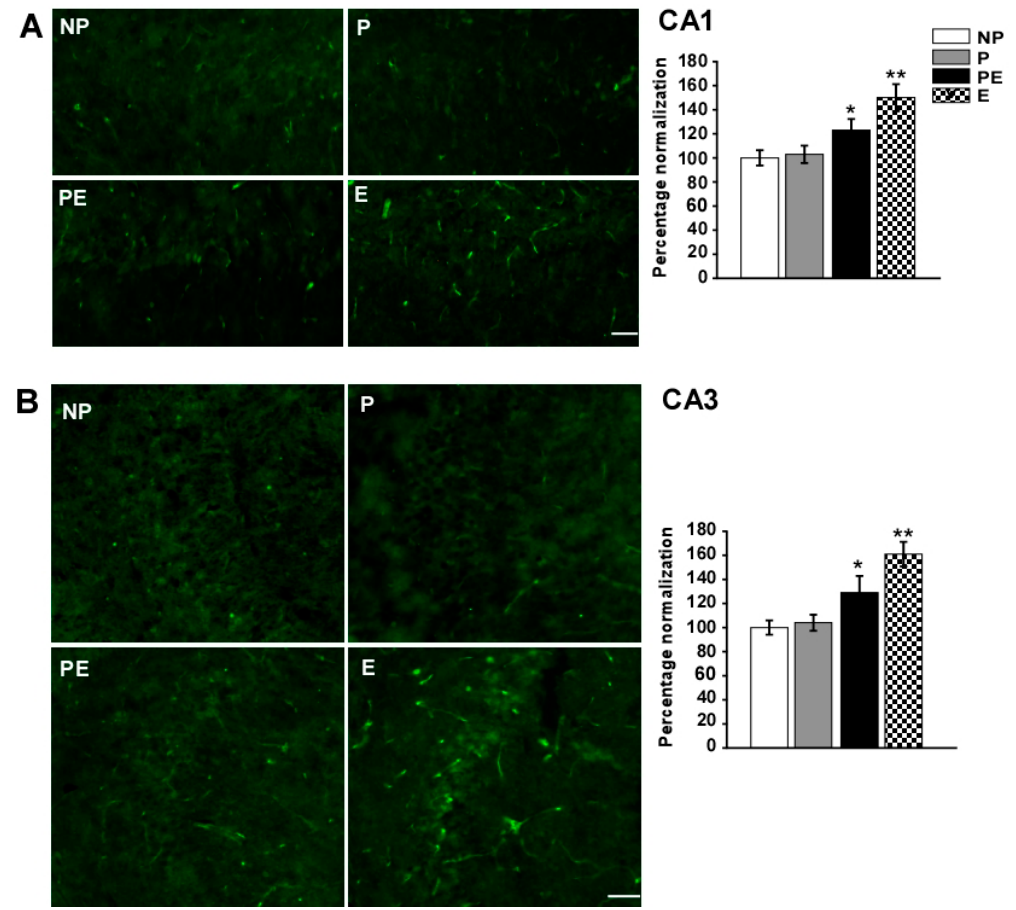
Figure 6. Changes in AQP9 immunoreactivity in the CA1 and CA3 areas after eclampsia were detected by immunofluorescent labeling ( n = 6). Immunofluorescent micrographs showing changes in fluorescence intensity of AQP9 in the CA1 ( A ) and CA3 area ( B ). Histograms showed the fluorescence intensity analysis of AQP9 in the CA1 and CA3 areas in all groups. * p < 0.05, PE group vs. NP and P groups. ** p < 0.05, E group vs. PE group. Scale bar = 50 µm.